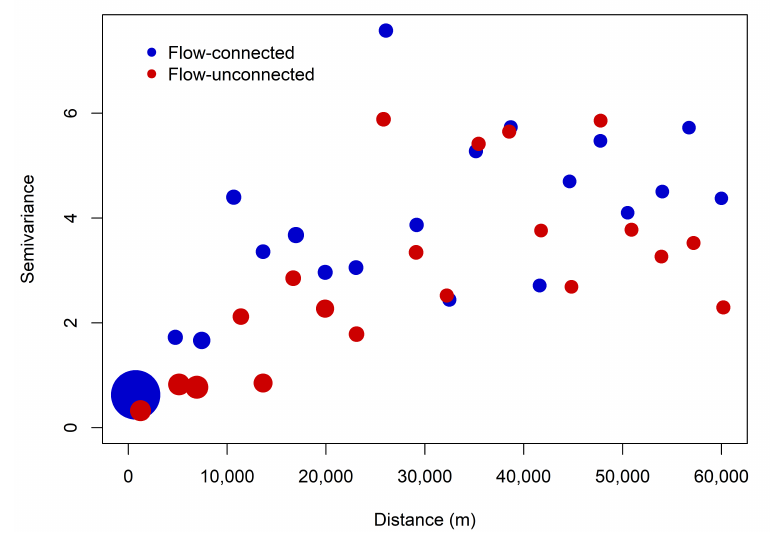
Figure 6. Empirical torgegram for flow-connected pairs (blue) and semivariogram for flow-unconnected pairs (red) in the network. The size of each point represents the number of pairs used to estimate the semivariance at each distance lag. The distance between flow-connected pairs corresponds to the stream distance, which is the shortest path between them following the network